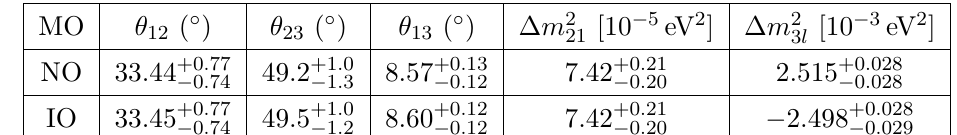
is ∆ m 2 when 31 3 l